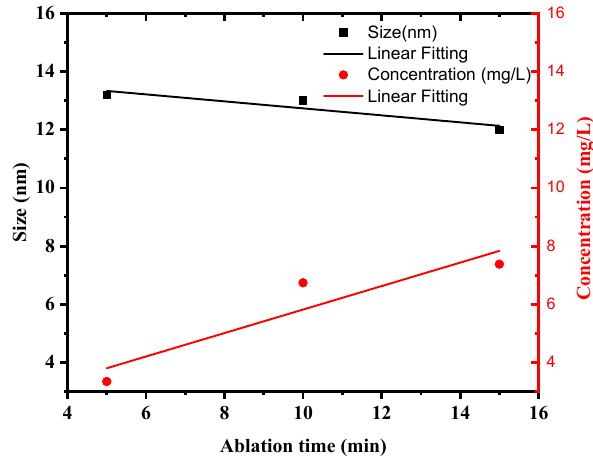
Figure 7. Dependence of AgNP concentration and size on ablation time.